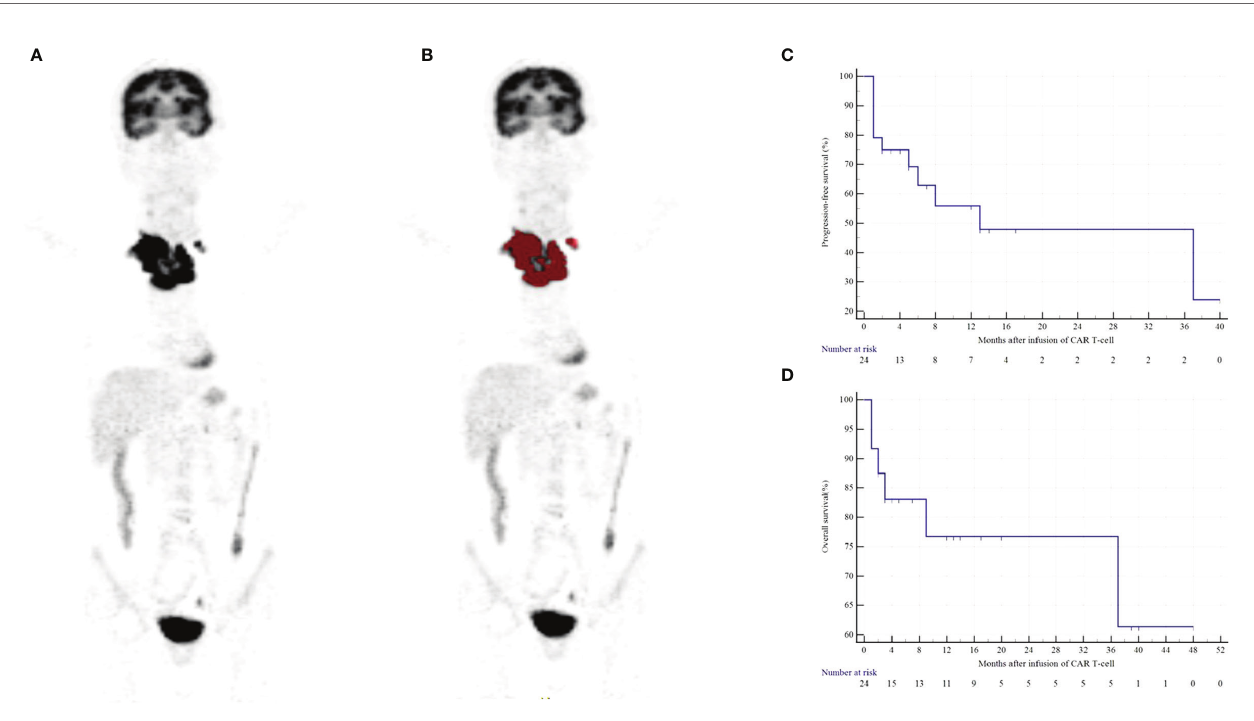
FIGURE 3 | Clinical outcomes of the BCL patients following the infusion of CD19/CD22 dual-targeted CAR T-cells. A patient with a high-risk NGLDM_Contrast PET (> 0.468) and positive-DE showed progression after 5 months and died 9 months after CAR T-cell therapy (A, B) . Kaplan-Meier curves of PFS (C) and OS (D)